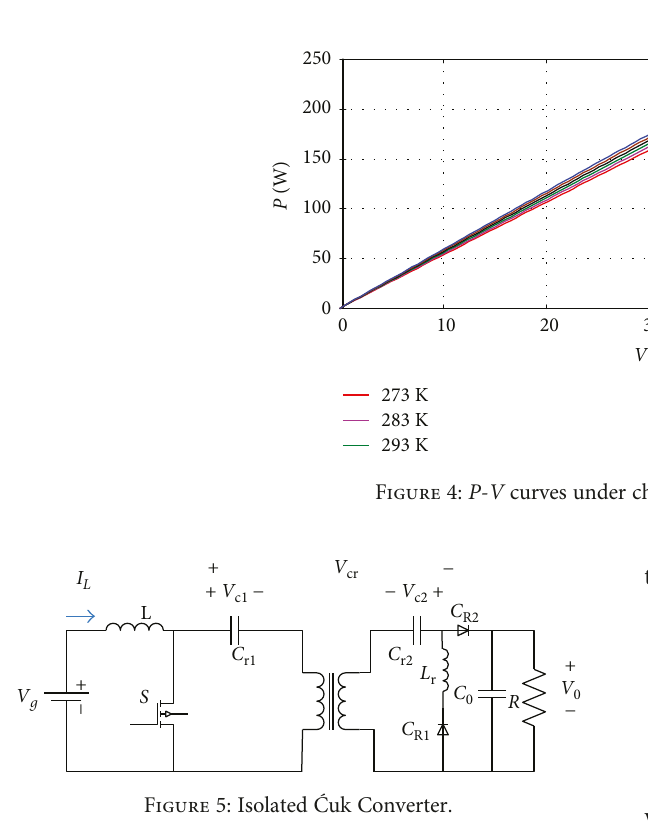
Figure 3: P - V curves under changing the solar radiation.